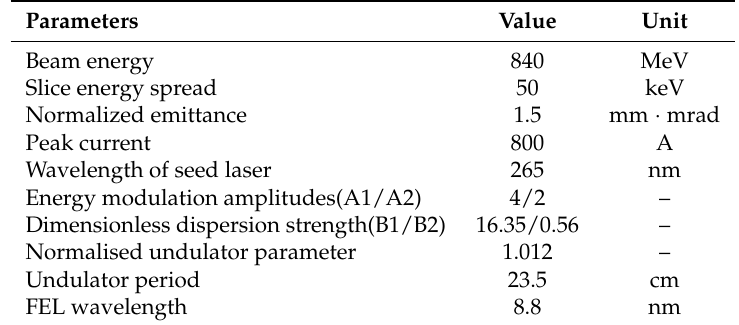
Table 2. Simulation Parameters for the echo-enabled harmonic generation (EEHG). Parameters Value Unit Beam